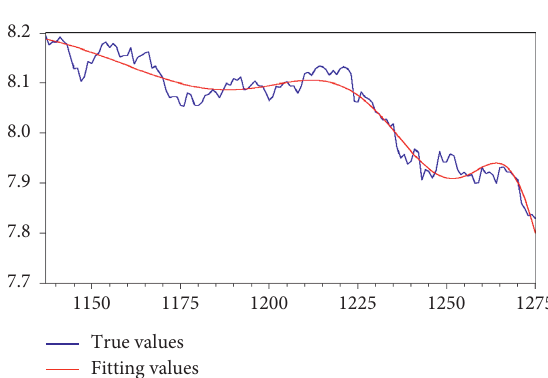
Figure 17: Fitting results from 2012/12 to